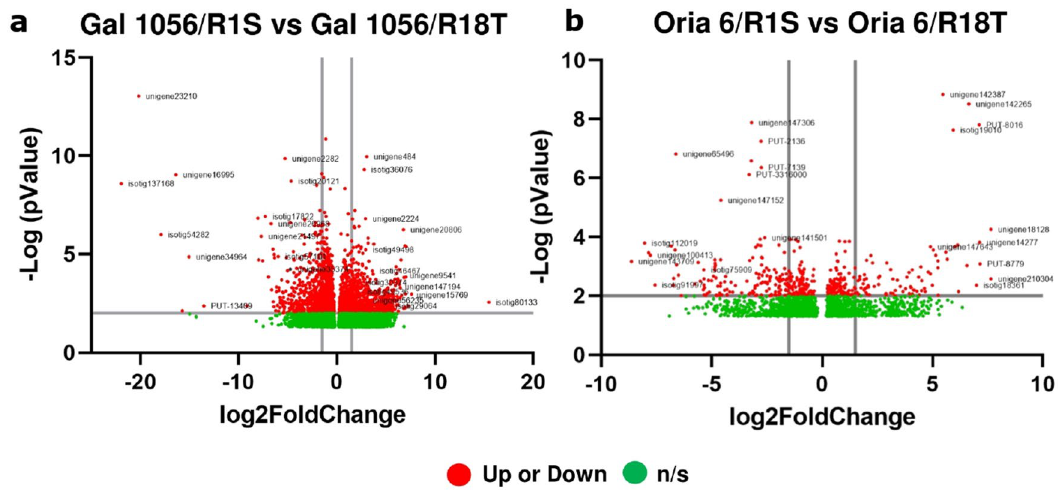
Figure 4. Volcano plots of differential expression profiles comparing genes differentially expressed in needle scions of ( a ) Gal 1056/R1S versus Gal 1056/R18T and ( b ) Oria 6/R1S versus Oria 6/R18T grafts (up or down: significantly upregulated or downregulated genes [Log2FC ≤ − 1.5 and Log2FC ≥ 1.5]; n/s: no significant genes). The list of the genes is provided in Supplementary Table 3 and Supplementary Table 4. P values ( P < 0.05) were calculated according to the Wald